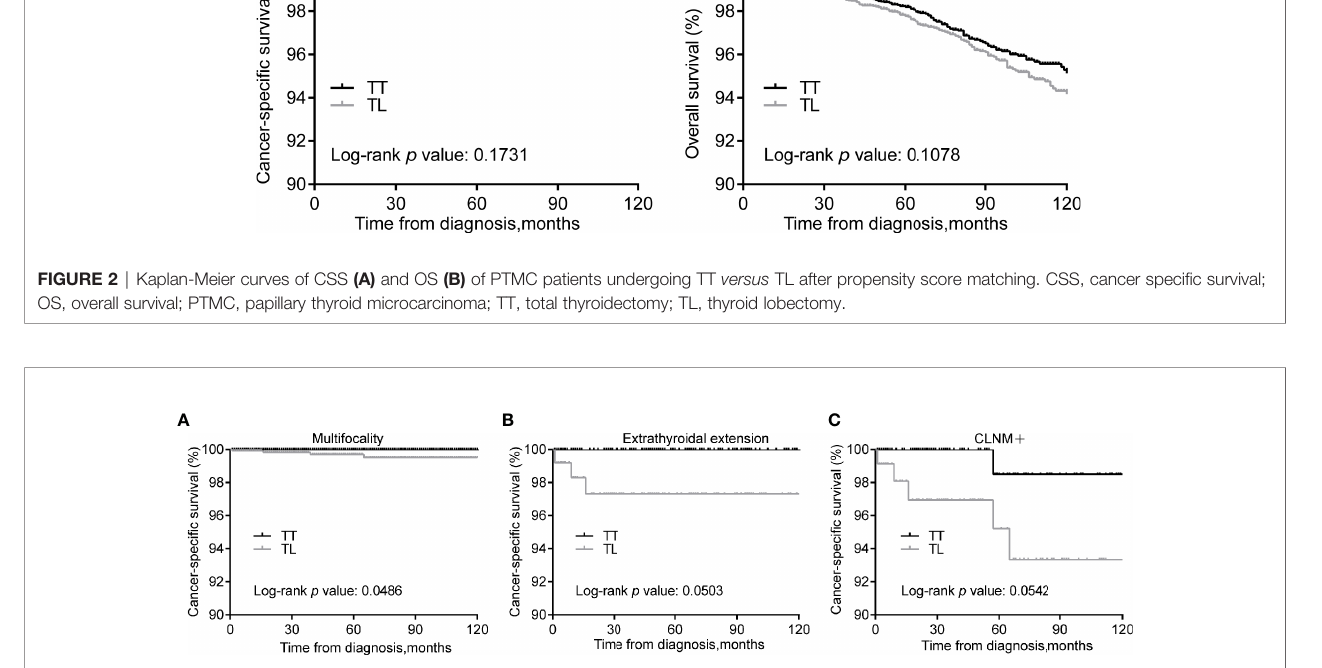
FIGURE 3 | Kaplan-Meier curves of CSS of PTMC underwent TT versus TL among patients with multifocality (A) , extrathyroidal extension (B) , and CLNM (C) after propensity score matching. CSS, cancer speci fi c survival; PTMC, papillary thyroid microcarcinoma; TT, total thyroidectomy; TL, thyroid lobectomy; CLNM, cervical lymph node